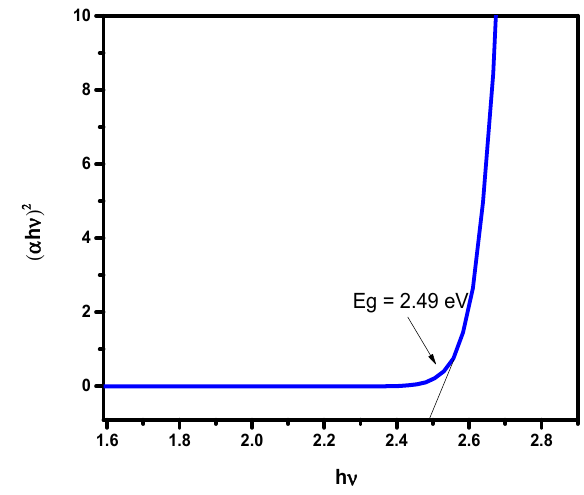
Figure 7. Tauc plot of the CS-NM bio-composite.